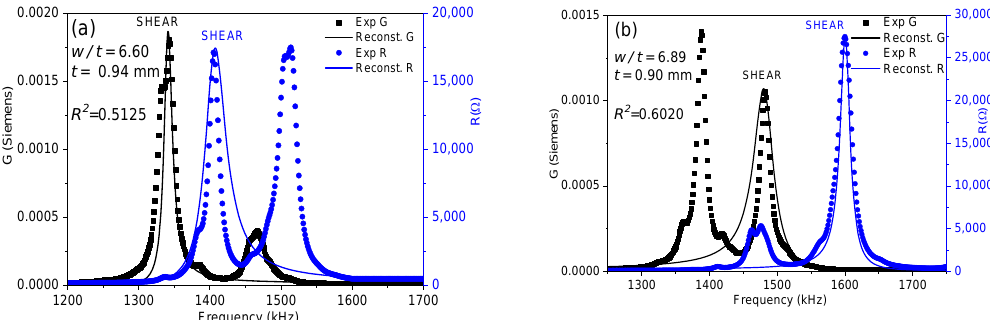
Figure 6. Impedance spectra showing coupled modes for the BCZT plate for aspect ratios ( a ) w / t =6.60; ( b ) w / t =8.61. Experimental G and R peaks (symbols), also shown in Figure 4, together with the reconstructed peaks using the material coefficients determined by the modified automatic iterative method (solid lines), are displayed.